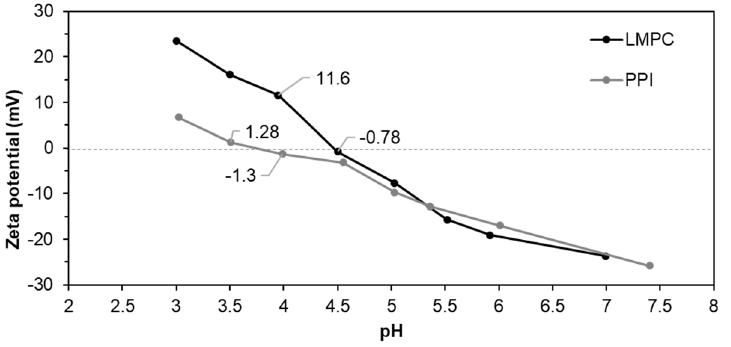
Figure A1. Zeta potential of LMPC (lesser mealworm protein concentrate) and PPI (pea protein isolate) solutions at pH range of 3.0–7.5.